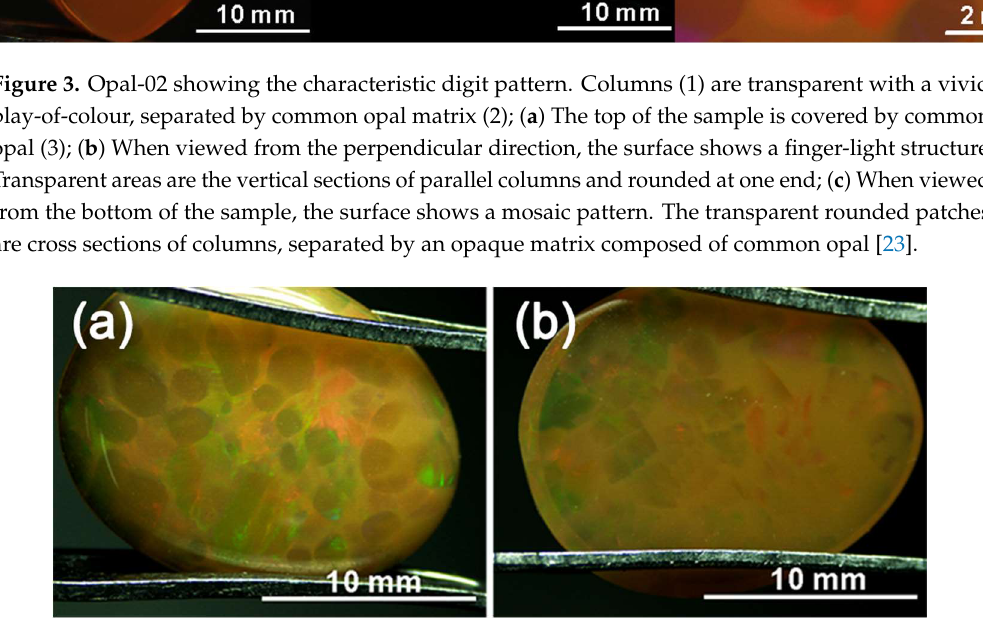
Figure 4. Play-of-colour is shown on both columns and matrix in Opal-05. The shape of the digits is very different. On the one side, ( a ) the cross section of the columns is near-circular, and on the other side ( b ) they are angular polygons.